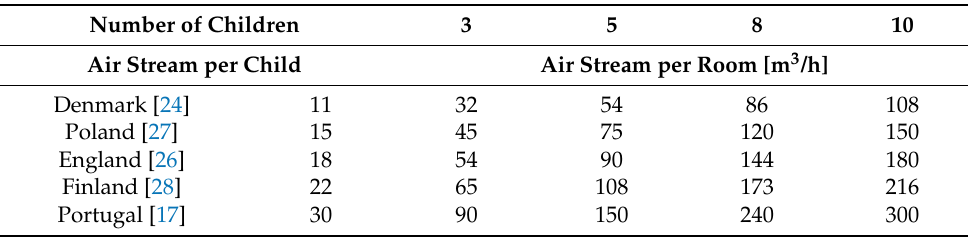
Table 2. Air stream of external (outdoor) air in relation to the number of children according to the guidelines valid in different